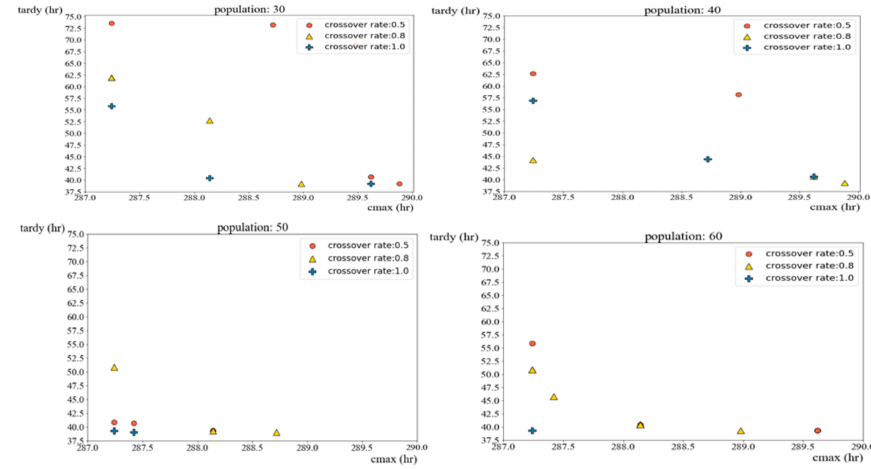
Figure 5. Pareto frontier solutions for different population numbers and mating rates.